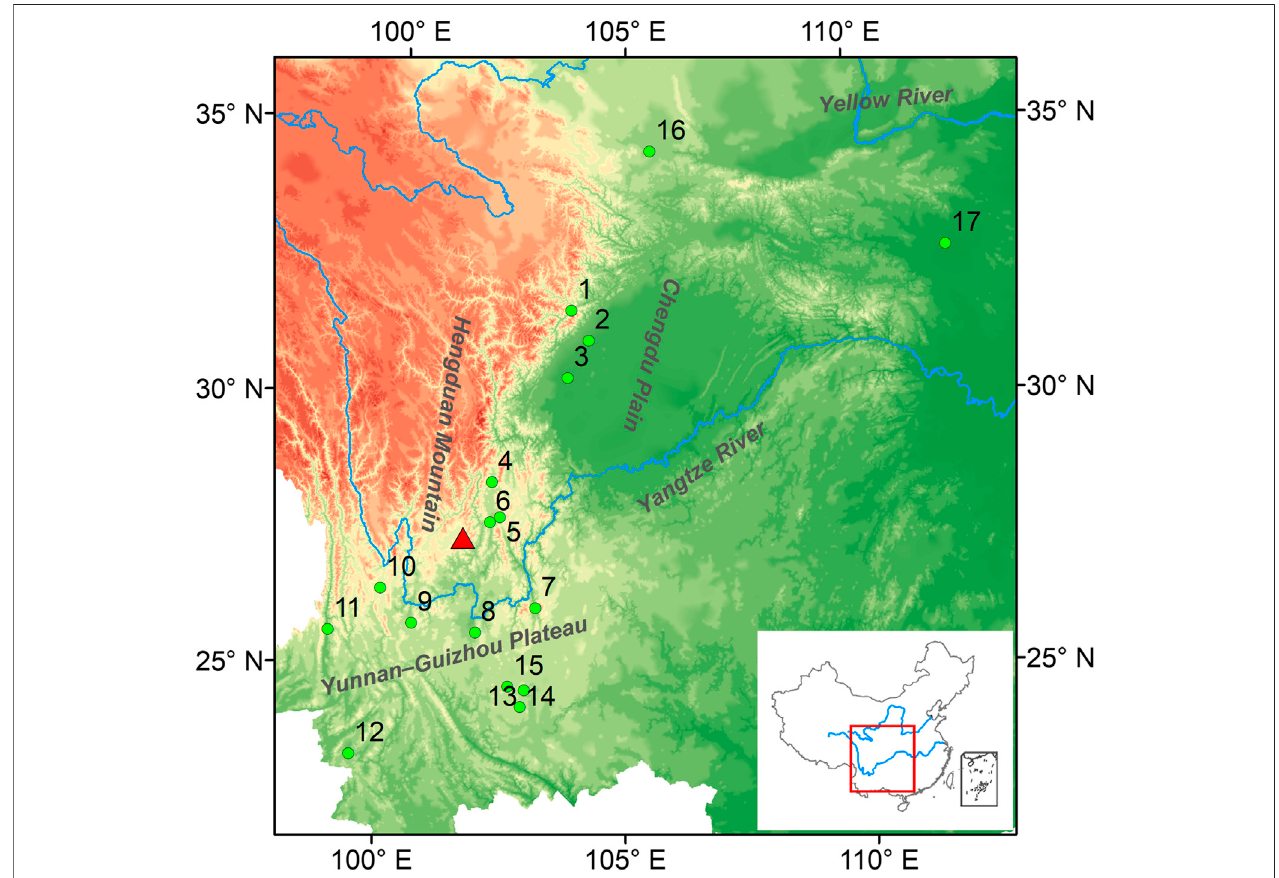
FIGURE 1 | Location of the Guijiabao site (red triangle) and other sites mentioned in the study. 1-Yingpanshan, 2-Guiyuanqiao, 3-Baodun, 4-Gaopo, 5- Henglanshan, 6-Shapingzhan, 7-Yubeidi, 8-Dadunzi, 9-Baiyangcun, 10-Haimenkou, 11-Shilinggang, 12-Shifodong, 13-Xueshan, 14-Guangfentou, 15-Heposuo,16- Xishanping,